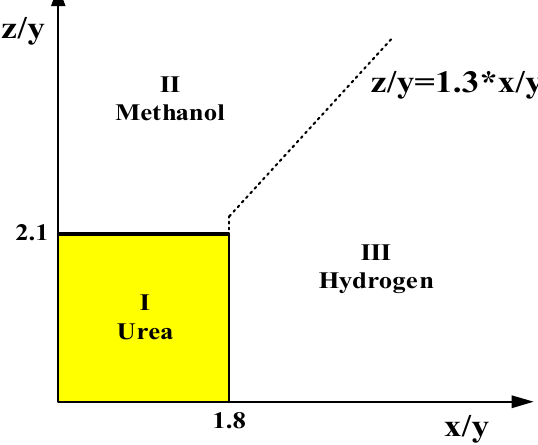
Figure 7. The choice of different utilization way of COG.